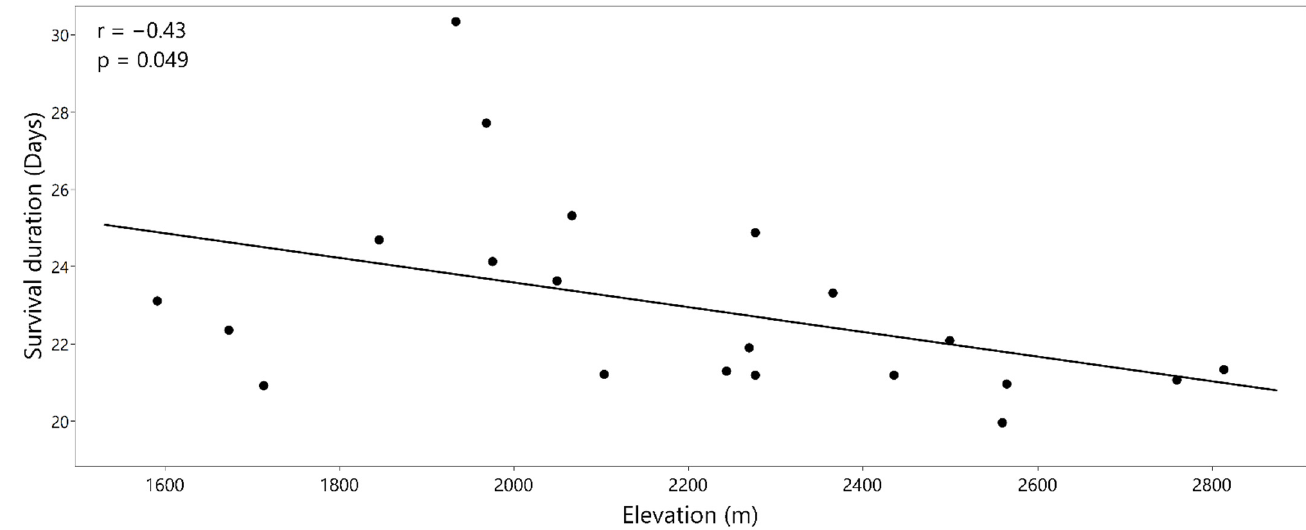
Figure 3. Relationship between mean survival duration since outplanting and provenance elevation (m) at the low-elevation site.